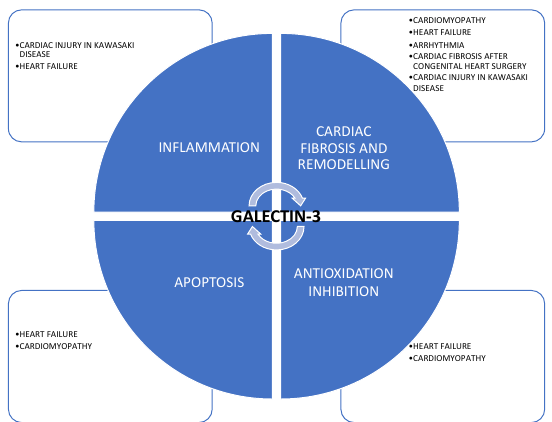
Figure 1. Possible mechanisms of action of galectin-3 in cardiovascular